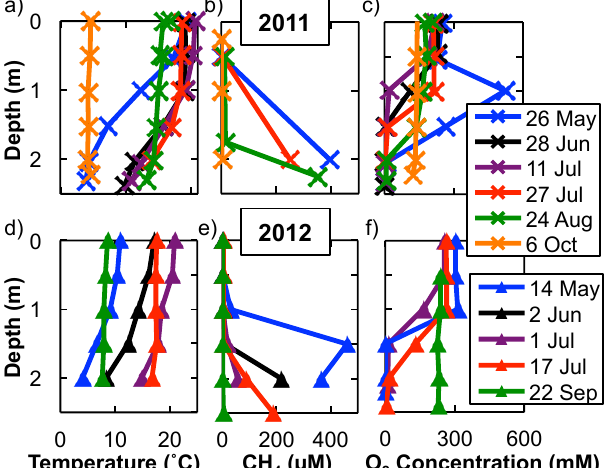
Figure 9. Measured depth profiles of (a, d) temperature, (b, e) dis- solved CH 4 concentration, and (c, f) dissolved O 2 concentration in the water column of Goldstream Lake during the summers of 2011 and 2012. 2011 profiles indicate that fall overturn had occurred by 6 October